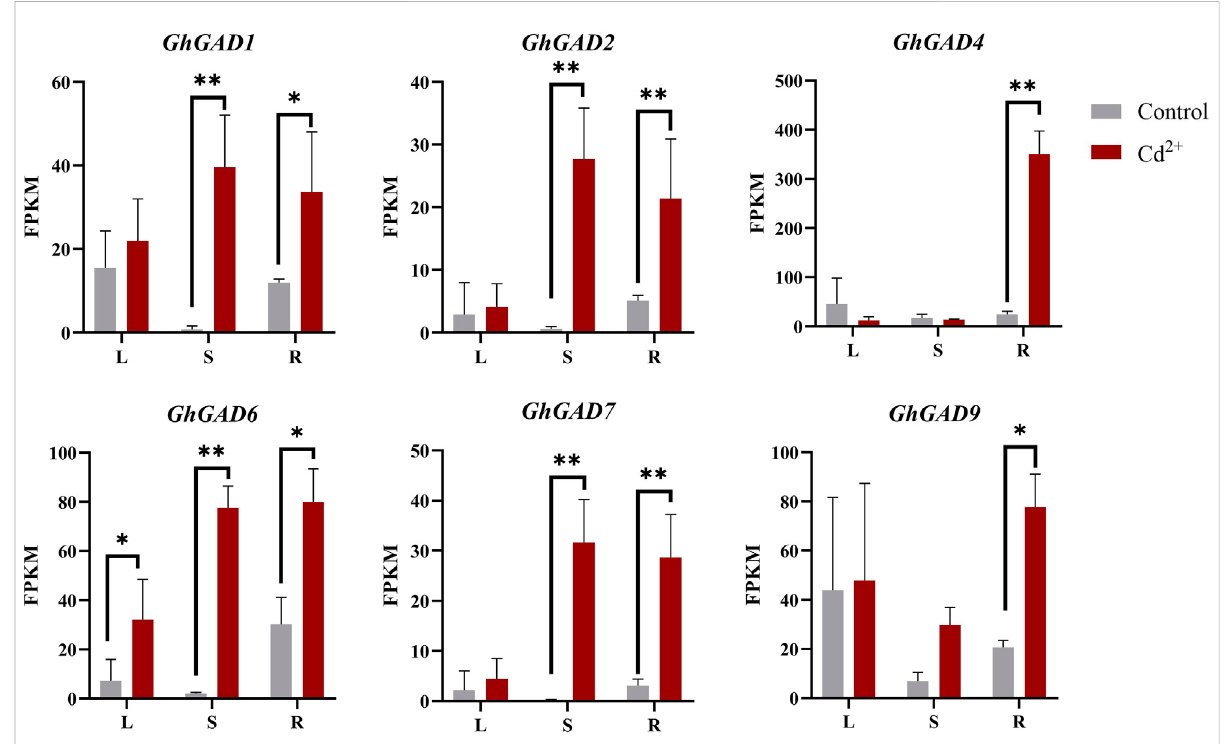
FIGURE 9 Expression analysis of clade Ⅲ GhGAD gene family members in different tissues under 4 mM Cd 2+ treatment for 9 h. L, leaf; S, stem; R, root. *0.01 < p < 0.05, ** p <